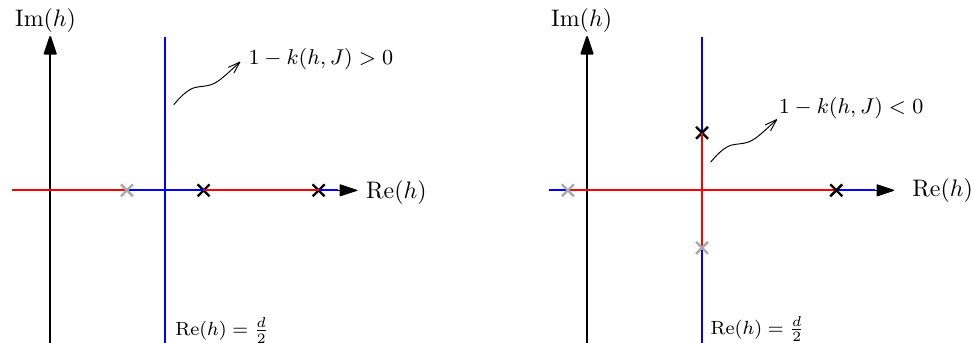
Figure 2 . Illustration in the complex h plane of some hypothetical solutions of k ( h, J ) = 1 . Physical solutions are represented by black crosses, while their shadow by gray crosses. On the principal series (vertical line) and the real line we have marked in blue the intervals with 1 − k ( h, J ) > 0 and in red those with 1 − k ( h, J ) < 0 . On the left panel all solutions are real, while on the right panel the smallest physical one has merged with its shadow to form a complex pair, thus leading to a negative interval on the principal series. Sign changes can occur also at poles of k ( h, J ) , which we have ignored here for